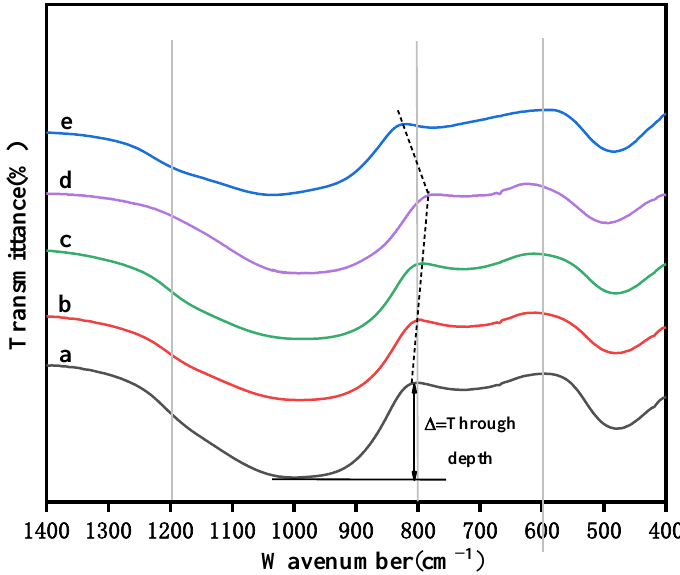
Figure 7. FTIR vibrational spectra of the samples: ( a ) 0 wt% Fe 2 O 3 ; ( b ) 3.11 wt% Fe 2 O 3 ; ( c ) 6.21 wt% Fe 2 O 3 ; ( d ) 9.32 wt% Fe 2 O 3 ; ( e ) 12.42 wt% Fe 2 O 3 .